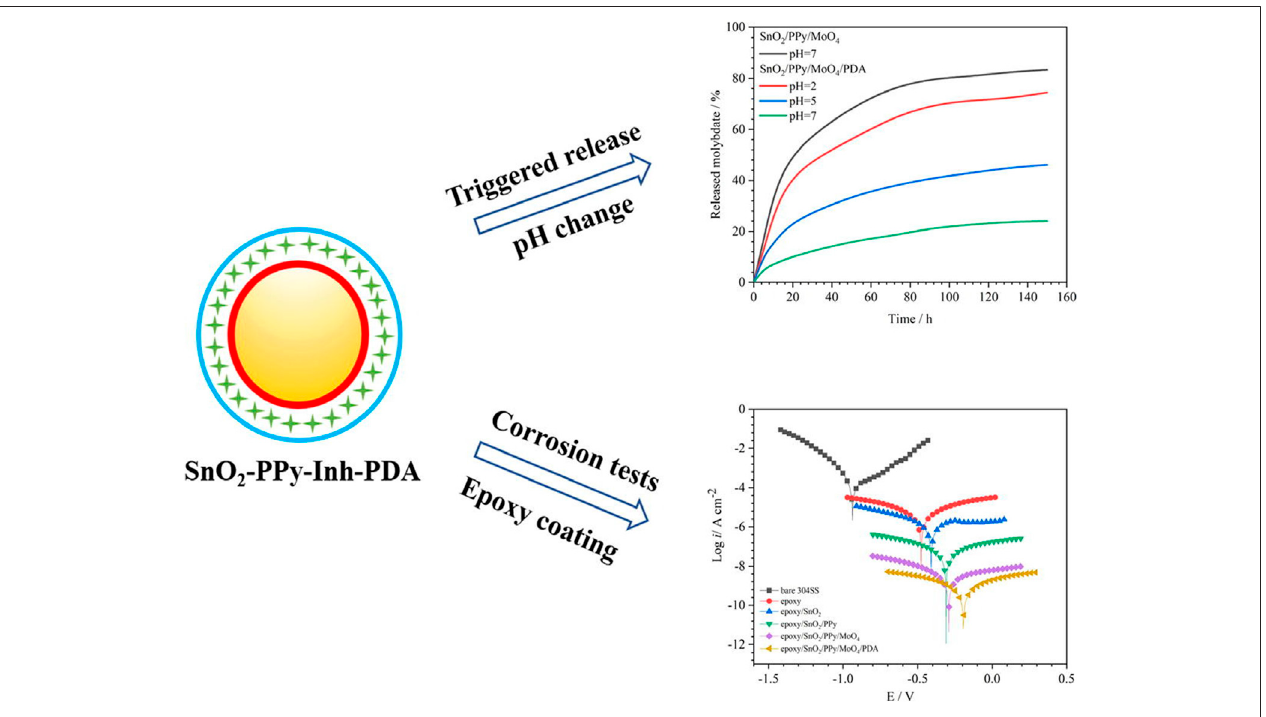
FIGURE 5 | Schematic illustration of SnO 2 -ppy-Inh-PDA (Chen et al., 2020a).